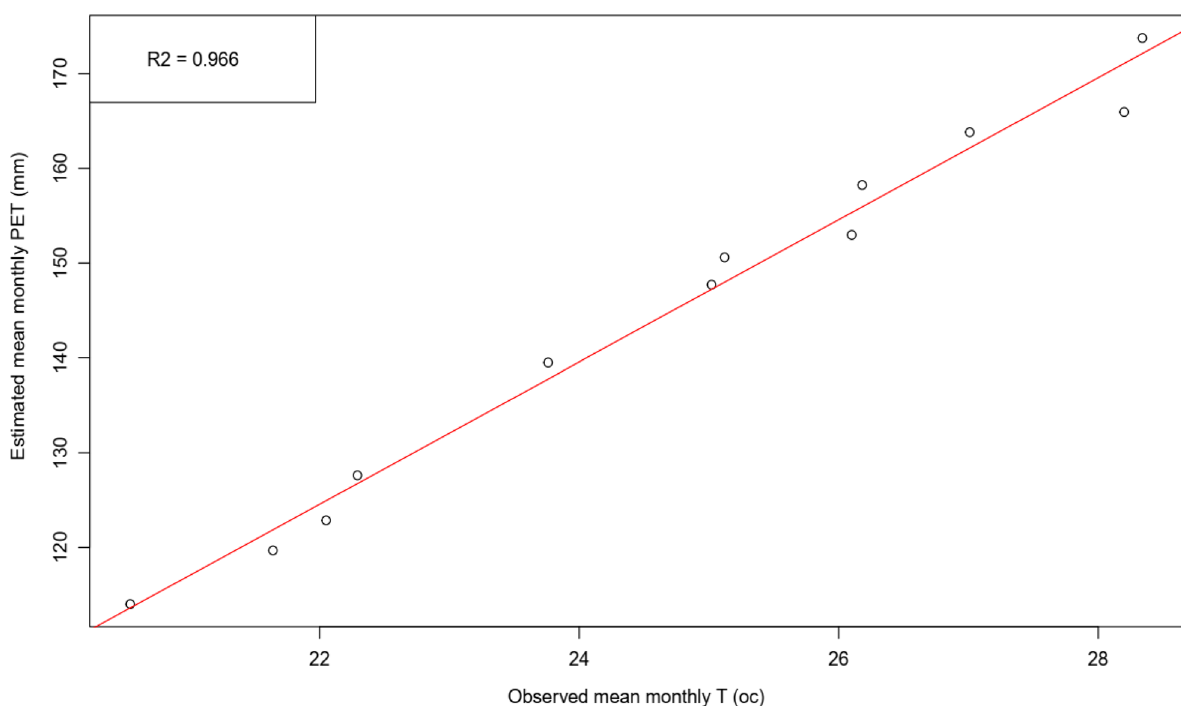
Fig. 6 Plot of the true linear relation between the estimated PET and the observed mean monthly temperature, and 12 estimations of the PET for mean monthly maximum temperature values from 1 through